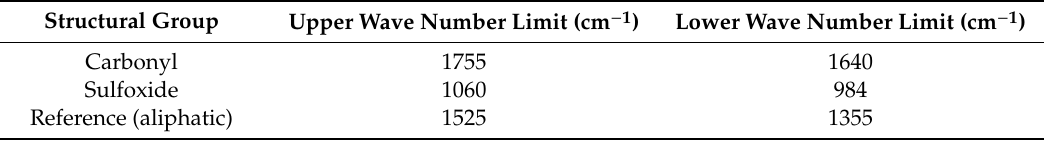
Table 3. Carbonyl and sulfoxide indices integration